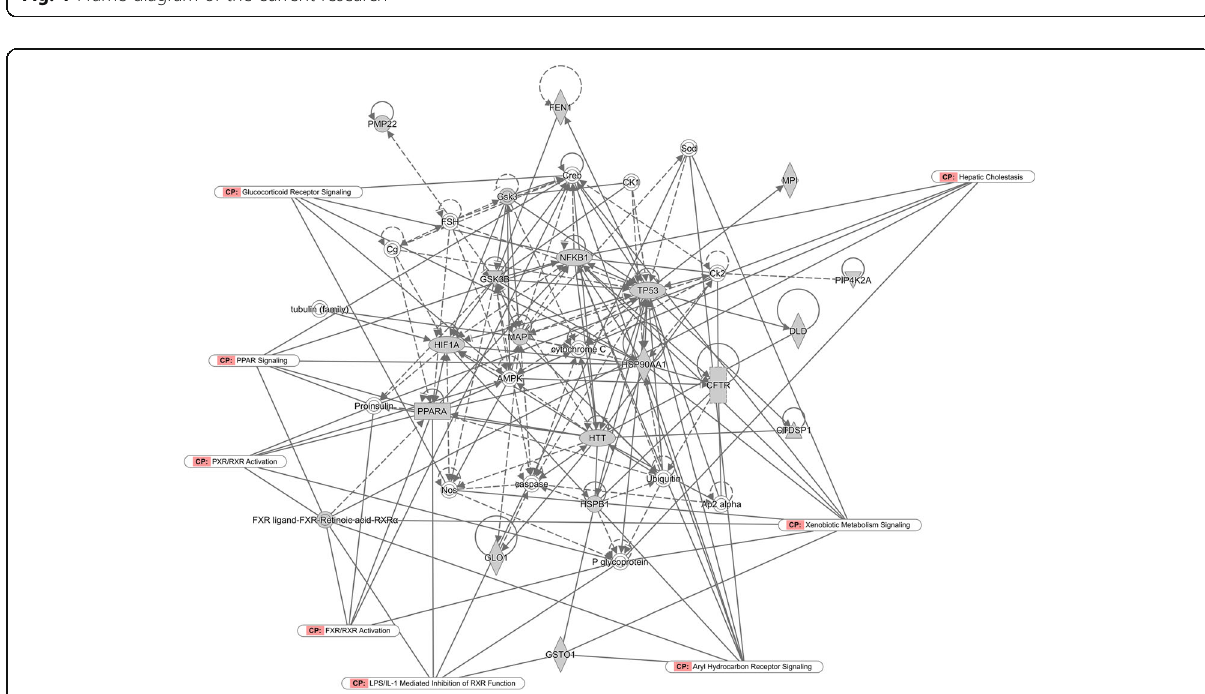
Fig. 1 Frame diagram of the current research